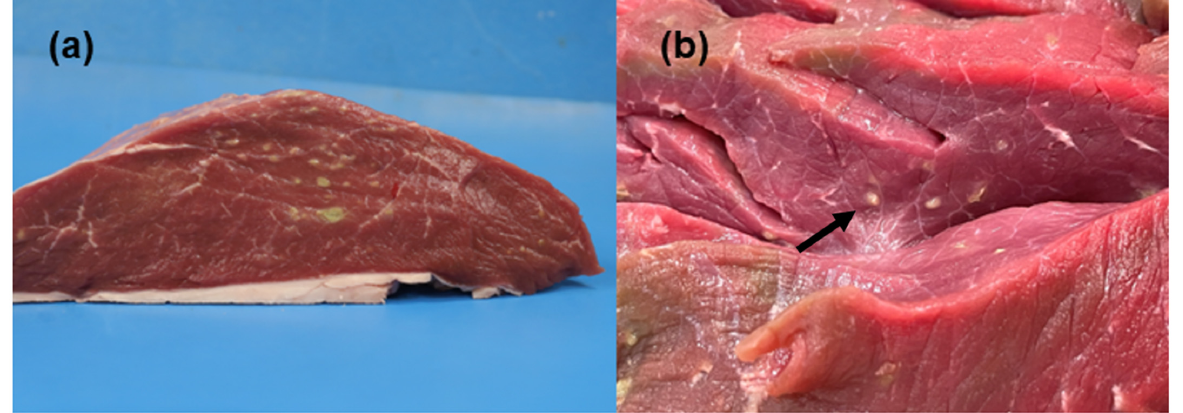
Figure 1. Macroscopic appearance of the infected skeletal muscle. ( a ) Note the multifocal yellowish- green round lesions, ranging from 0.1 to 1cm of diameter, with a necrotic content in a cross-section of skeletal muscle. ( b ) Note the white round lesions and a green discoloration area of the muscle (arrow).